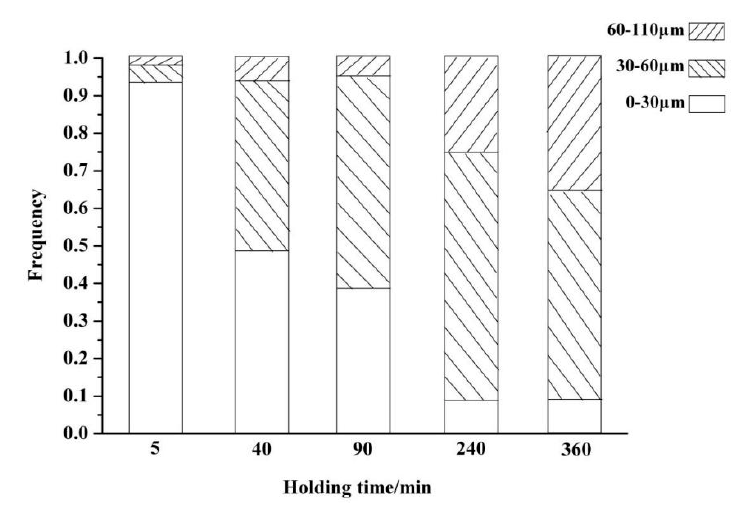
Figure 2. Frequency histogram of the grain size distribution for C 2 S with different holding times at 1673 K.